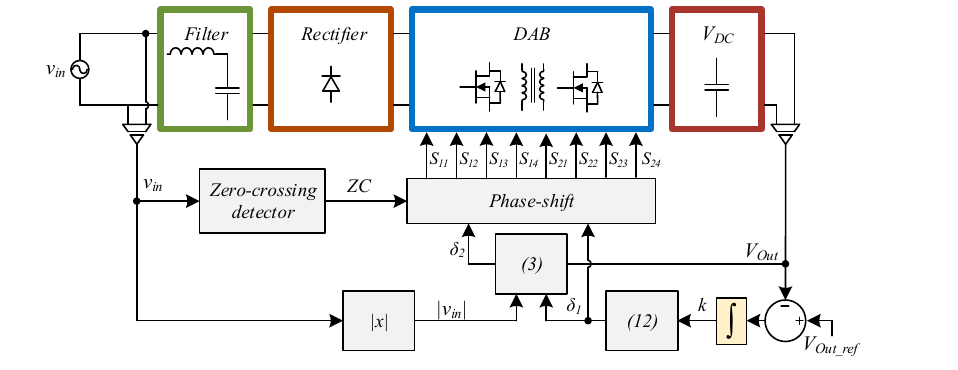
Figure 6. Proposed controller. Table 1. AC-DC DAB test parameters.